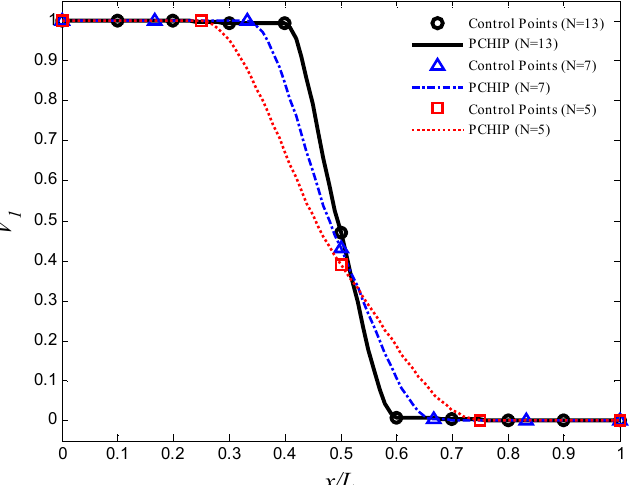
Table 7. The optimal frequencies and design variables of the second design problem.